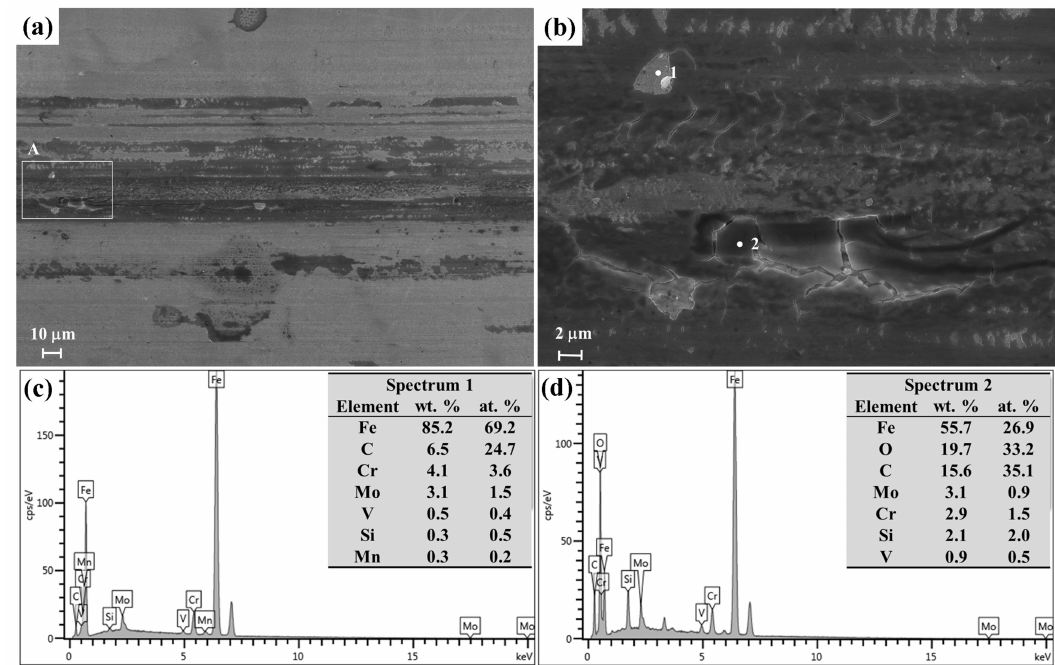
Figure 6. SEM/EDS wear topography characterization of bare (polished) M50 steel after sliding in pure JP-10 against a Si 3 N 4 ball under 2.0 GPa at room temperature in ambient atmosphere: ( a ) overview SEM topography; ( b ) high-magnification SEM image of region A; ( c , d ) EDS spectra of points 1 and 2,